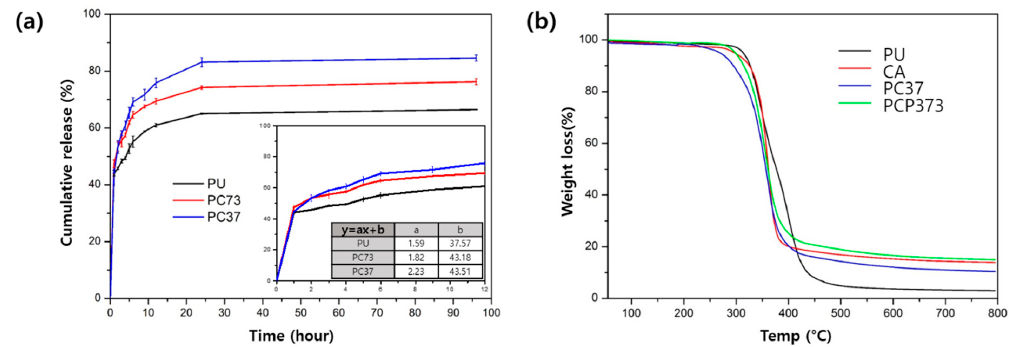
Figure 2. ( a ) Swelling behavior and thickness of PU and composite nanofibrous mats. ( b ) Optical image of the samples after swelling test. ( c ) The lyophilized PU, PC73, PC55, and PC37 membranes and respective thicknesses.